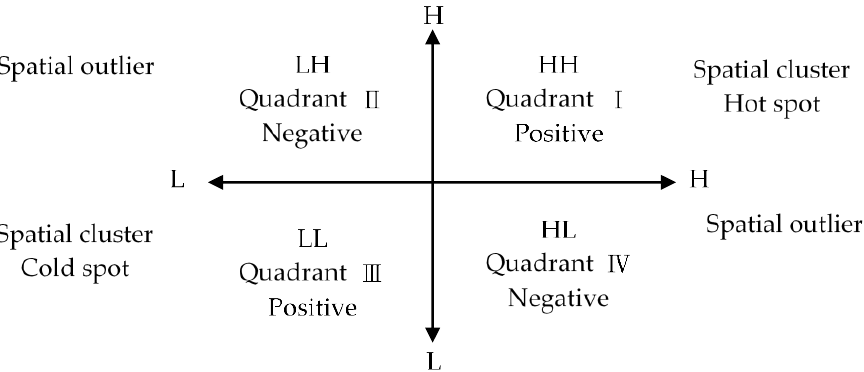
Figure 2. The local indicator of a spatial association (LISA) cluster. The second and fourth quadrants are indicators of negative spatial autocorrelation and are the areas where different values cluster. These quadrants show mutual exclusion effects, i.e., a negative influence of the changes in adjacent regions on the observed values. The second quadrant, Low-High, is where low observed values are surrounded by high values, while the fourth quadrant, High-Low, is where high observed values are surrounded by low values. Significantly negative spatial autocorrelation suggests great variance between the observed values in this region and the observed values in neighboring regions. This is called a spatial